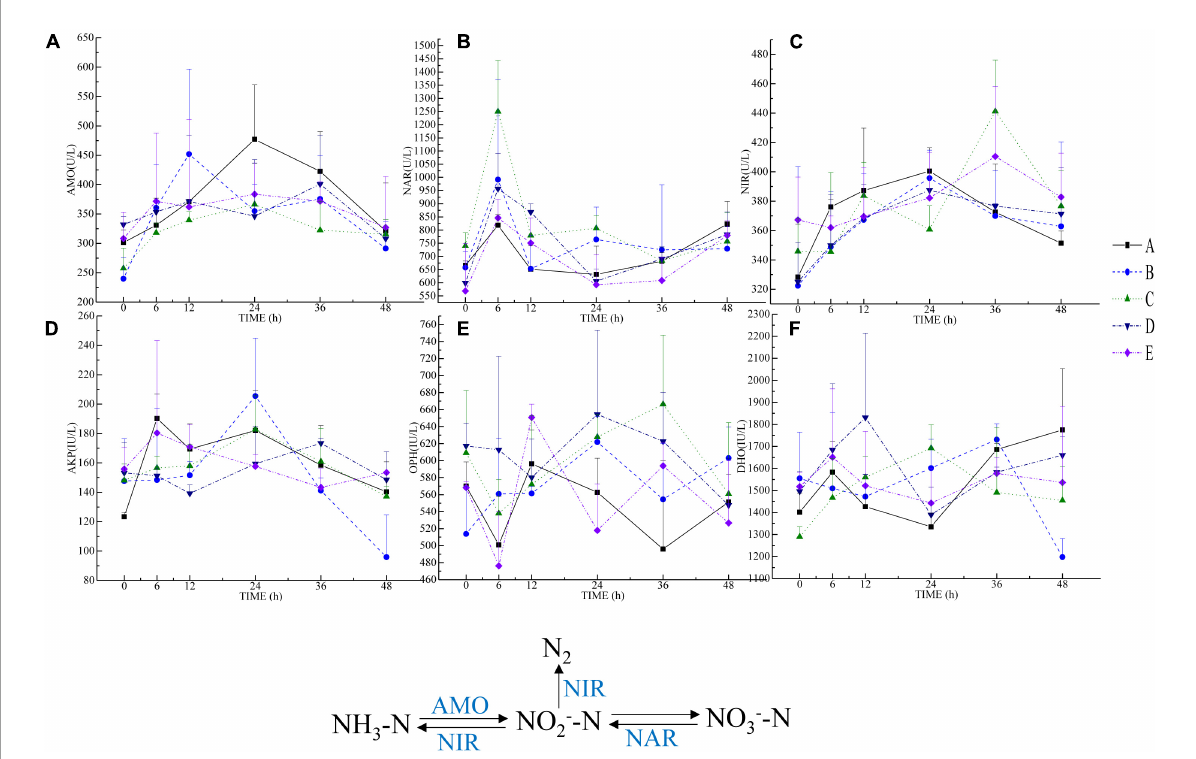
FIGURE3 Results of microbial enzyme activity determination. (A–F) pictures are AMO, NAR, NIR, AKP, OPH, and DHO, respectively. The NIR, NAR, and AMO participate in the nitrogen cycle. NIR degrades NO 2 − -N to N 2 or NH 3 -N, reducing the accumulation of NO 2 − -N in the environment. NAR is an inducible enzyme that can directly reduce NO 3 − -N to NO 2 − -N. AMO catalyzes ammonia oxidation by helping ammonia-oxidizing bacteria, which can help ammonia-oxidizing bacteria convert NH 3 -N to NO 2 − -N. AKP can catalyze the decomposition of organic phosphorus and release orthophosphate, while OPH can decompose organic phosphorus compounds in water and reduce organic phosphorus compound pollution. DHO is an oxidoreductase that participates in the decomposition of organic